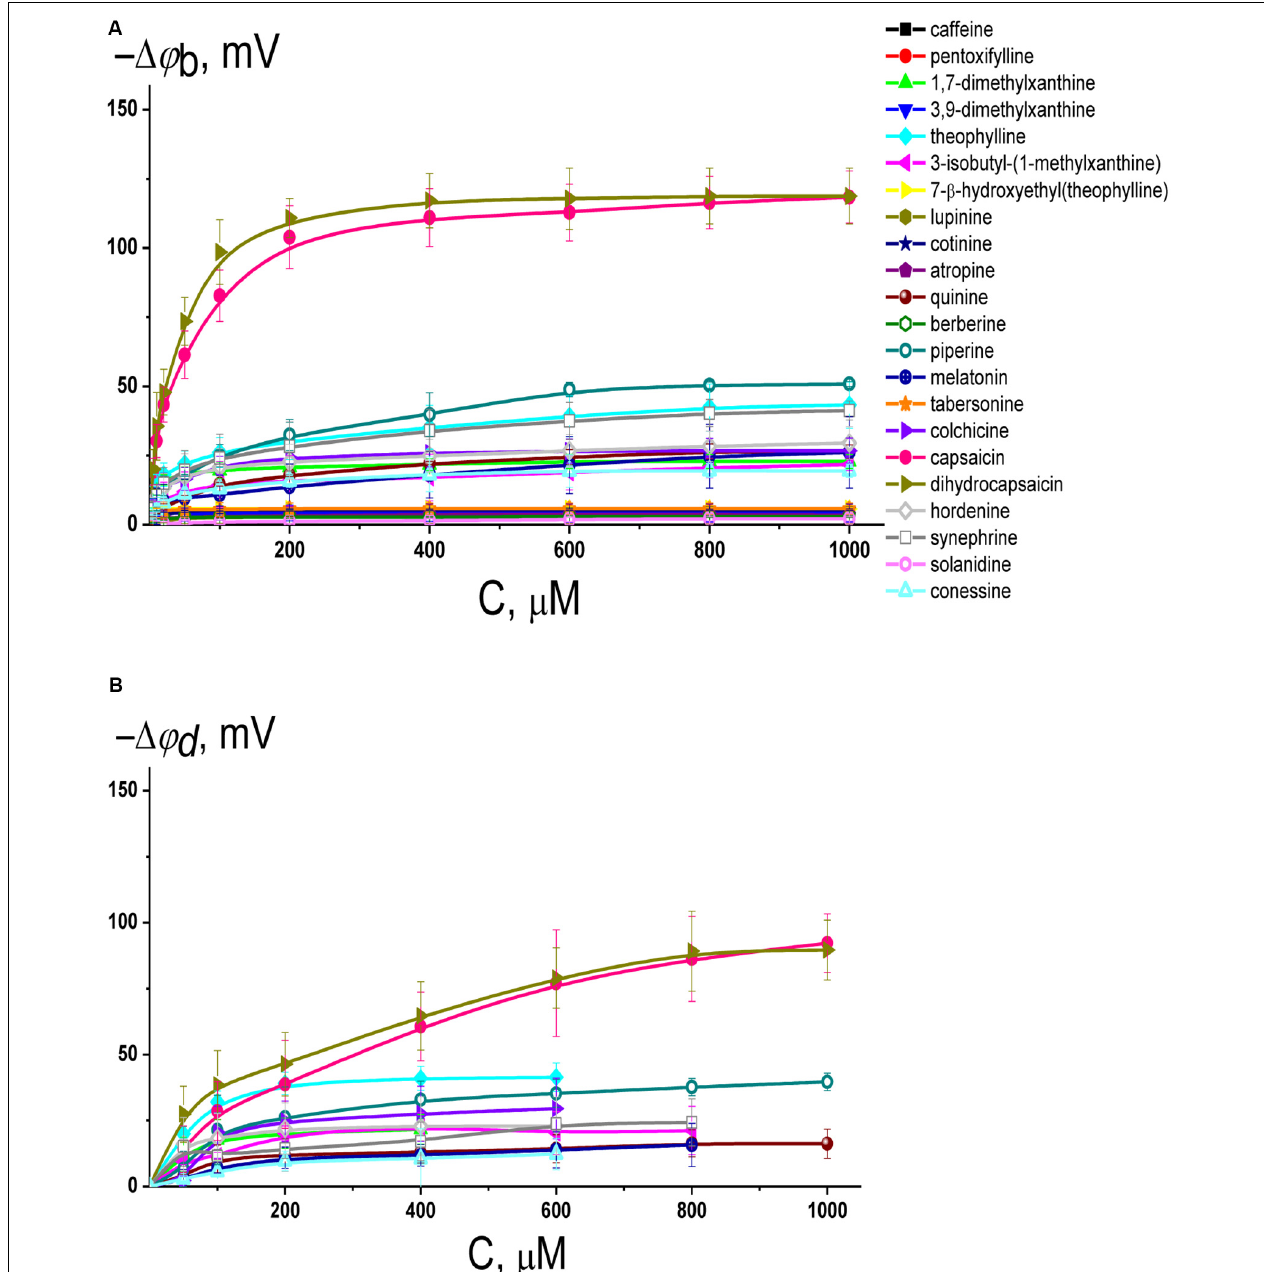
FIGURE 2 | (A) Dependence of the decrease in the boundary potential of the membrane (– (cid:49) ϕ b ) on the concentration ( C ) of different alkaloids in the membrane bathing solution. The membranes were made from POPC, bathed in 0.1 M KCl, pH 7.4, and modified by nonactin. V = 50 mV. The relation between the color symbol and the compound is given on the figure. (B) Dependence of the reduction in the dipole potential of the POPC membranes (– (cid:49) ϕ d ) on the concentration in the liposome bathing solution ( C ) of different alkaloids having the distinguishable boundary potential modifying ability ( > 10 mV). The membranes were modified with the dipole-sensitive fluorescence probe di-8-ANEPPS. The relation between the color symbol and the compound is the same as on panel (A) .